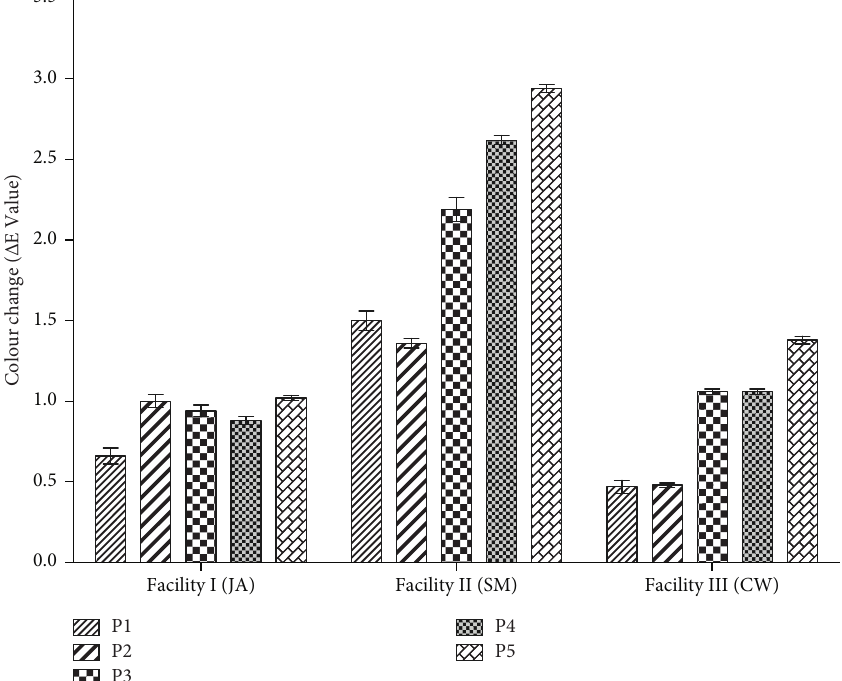
Figure 1: The colour changes of king coconut water among sampling points at each processing facility. Pre-identified five different sampling , P , P ,P , and P , respectively; three studied processing facilities are denoted as JA, SM, and CW. Error bars points are denoted as P 1 2 3 4 5 indicate Table 3: Changes in physicochemical parameters of king coconut water along the process line. Factory ID